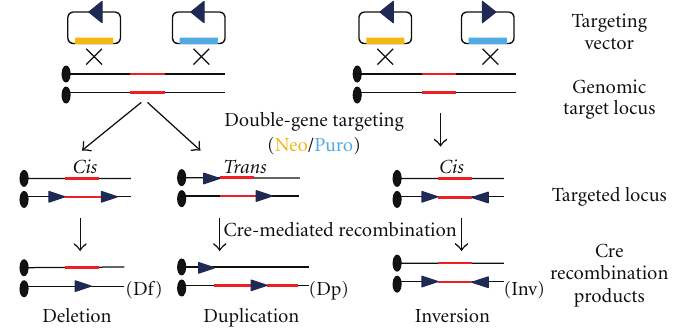
Figure 1: Chromosome engineering in mouse embryonic stem